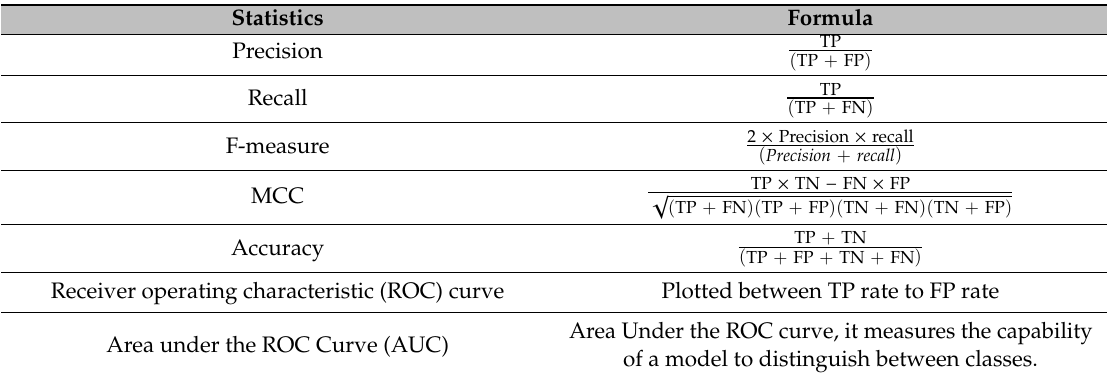
Table 2. Statistical measures used to access the performance of classification methods. Here TP stands for true positive, FP for false positive, FN for false negative, and FP for false